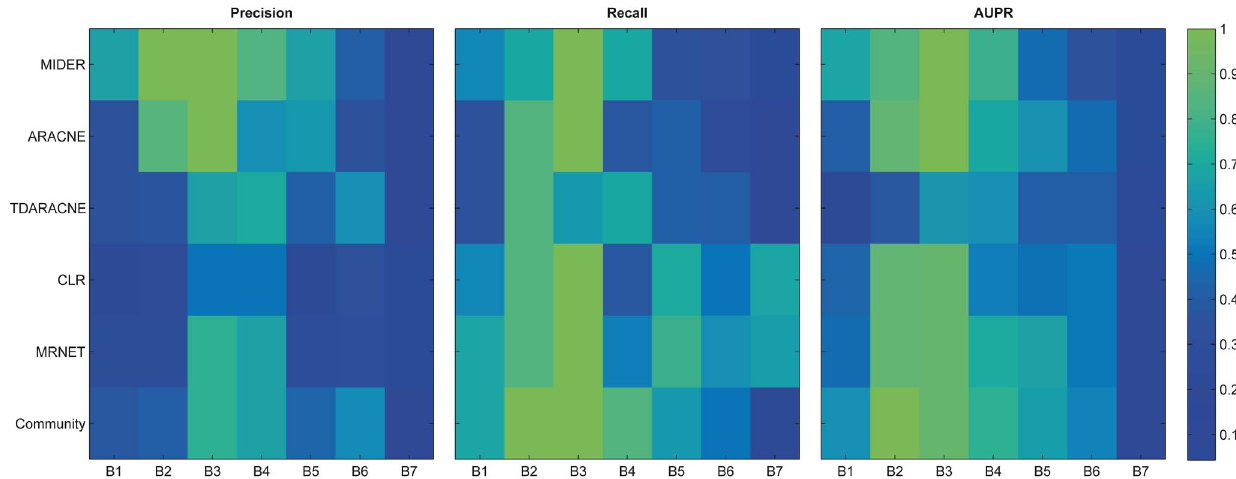
Figure 4. P, R, and AUPR. The color maps show precision (left panel) and recall (central panel) achieved by each method and for each benchmark with its default settings, as well as the area under precision-recall curve (AUPR, right panel). Numerical values are in the range [0–1], and are represented in colors according to the scale in the right (green = good, blue = bad).